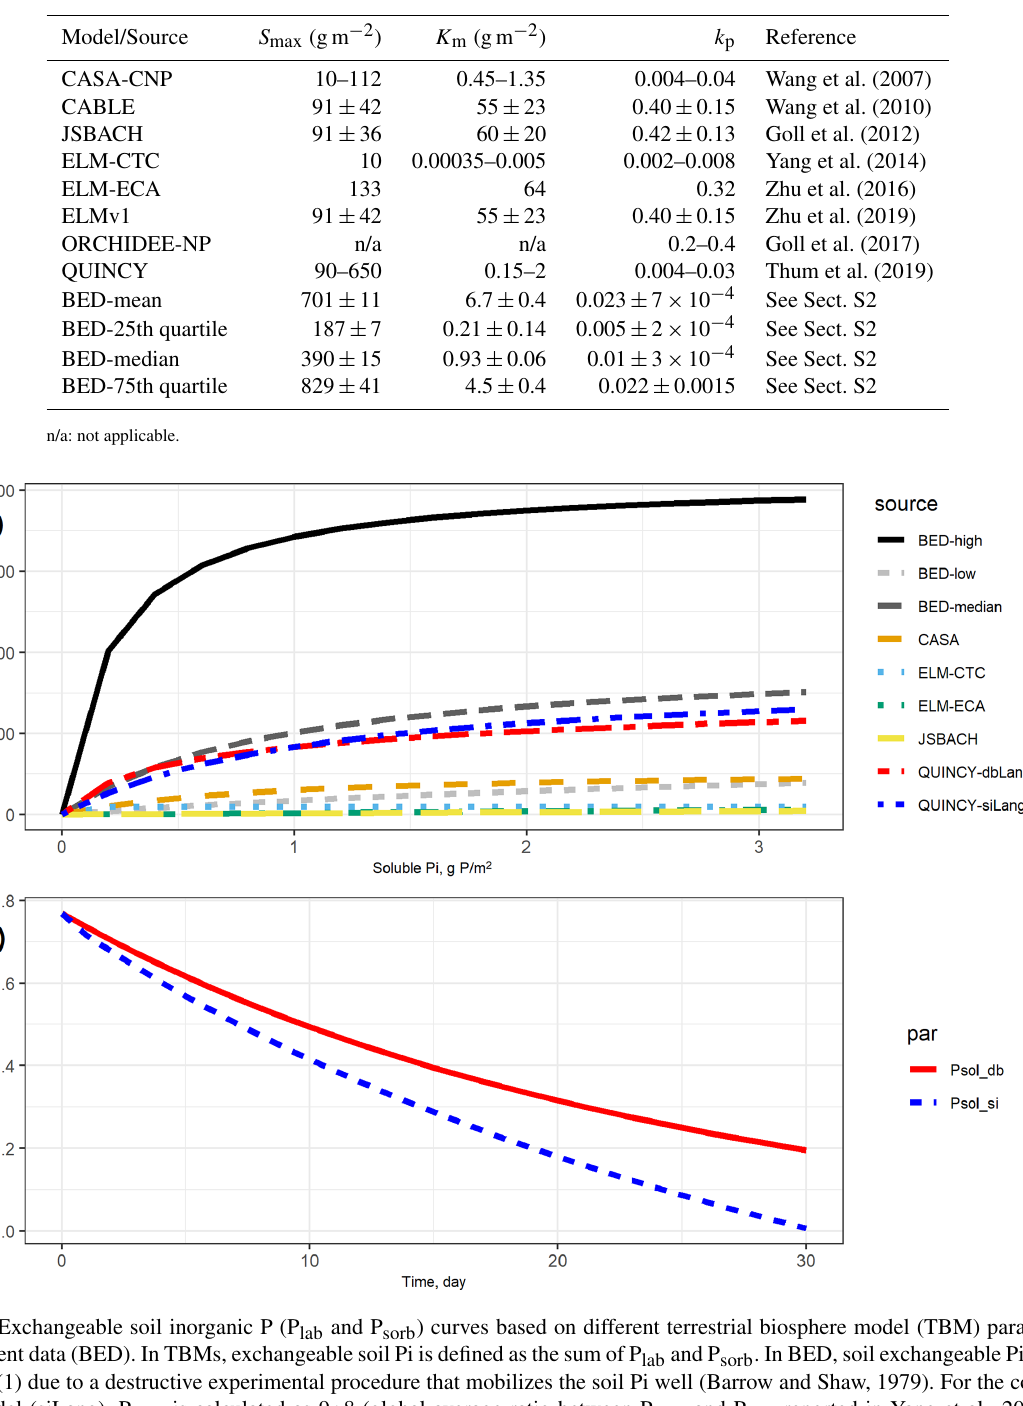
Table 2. The maximum sorption capacity ( S max ), the Langmuir coefficient ( K m ), and the calculated partition coefficient ( k p ) of the phos- phorus Langmuir (ad)sorption isotherm in TBMs and batch sorption experiment data (BED).